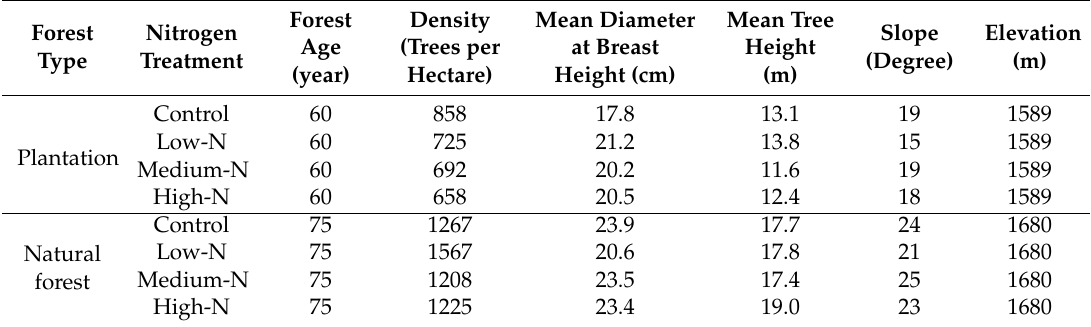
Table 1. Stand characteristics of four N addition treatment plots in the plantation and natural forests of Chinese